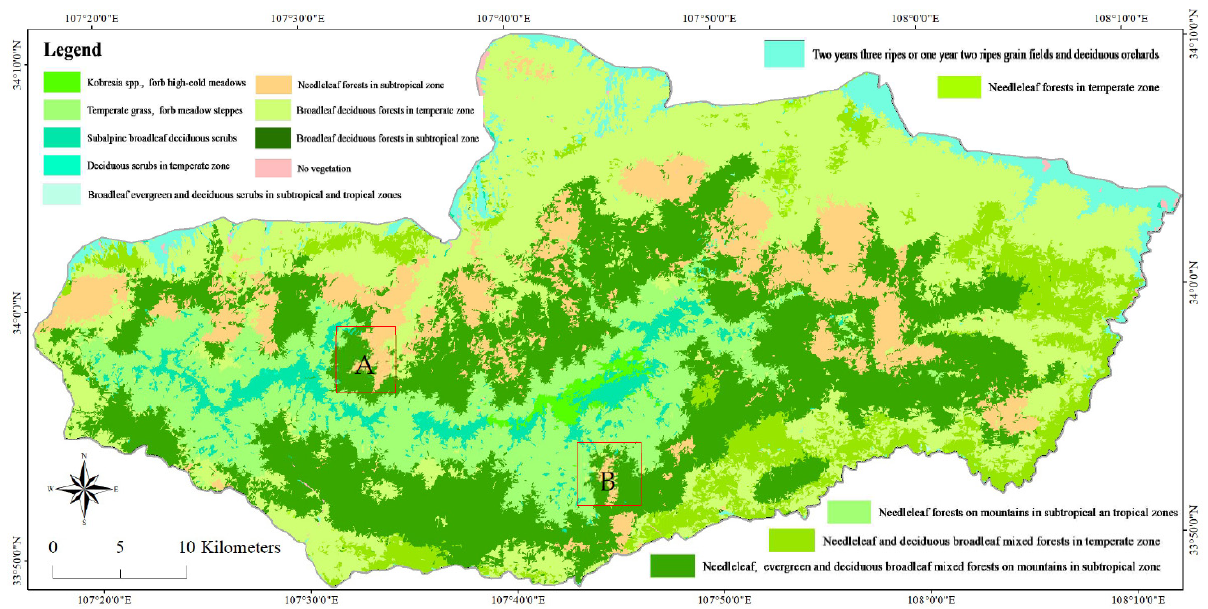
Figure 9. The vegetation mapping results using the collected geo-object samples according to the process of Figure 2 ( A and B are two subareas for detailed display in the following Figures 10 and 11). Table 4. Comparison of the accuracies achieved by different vegetation maps.